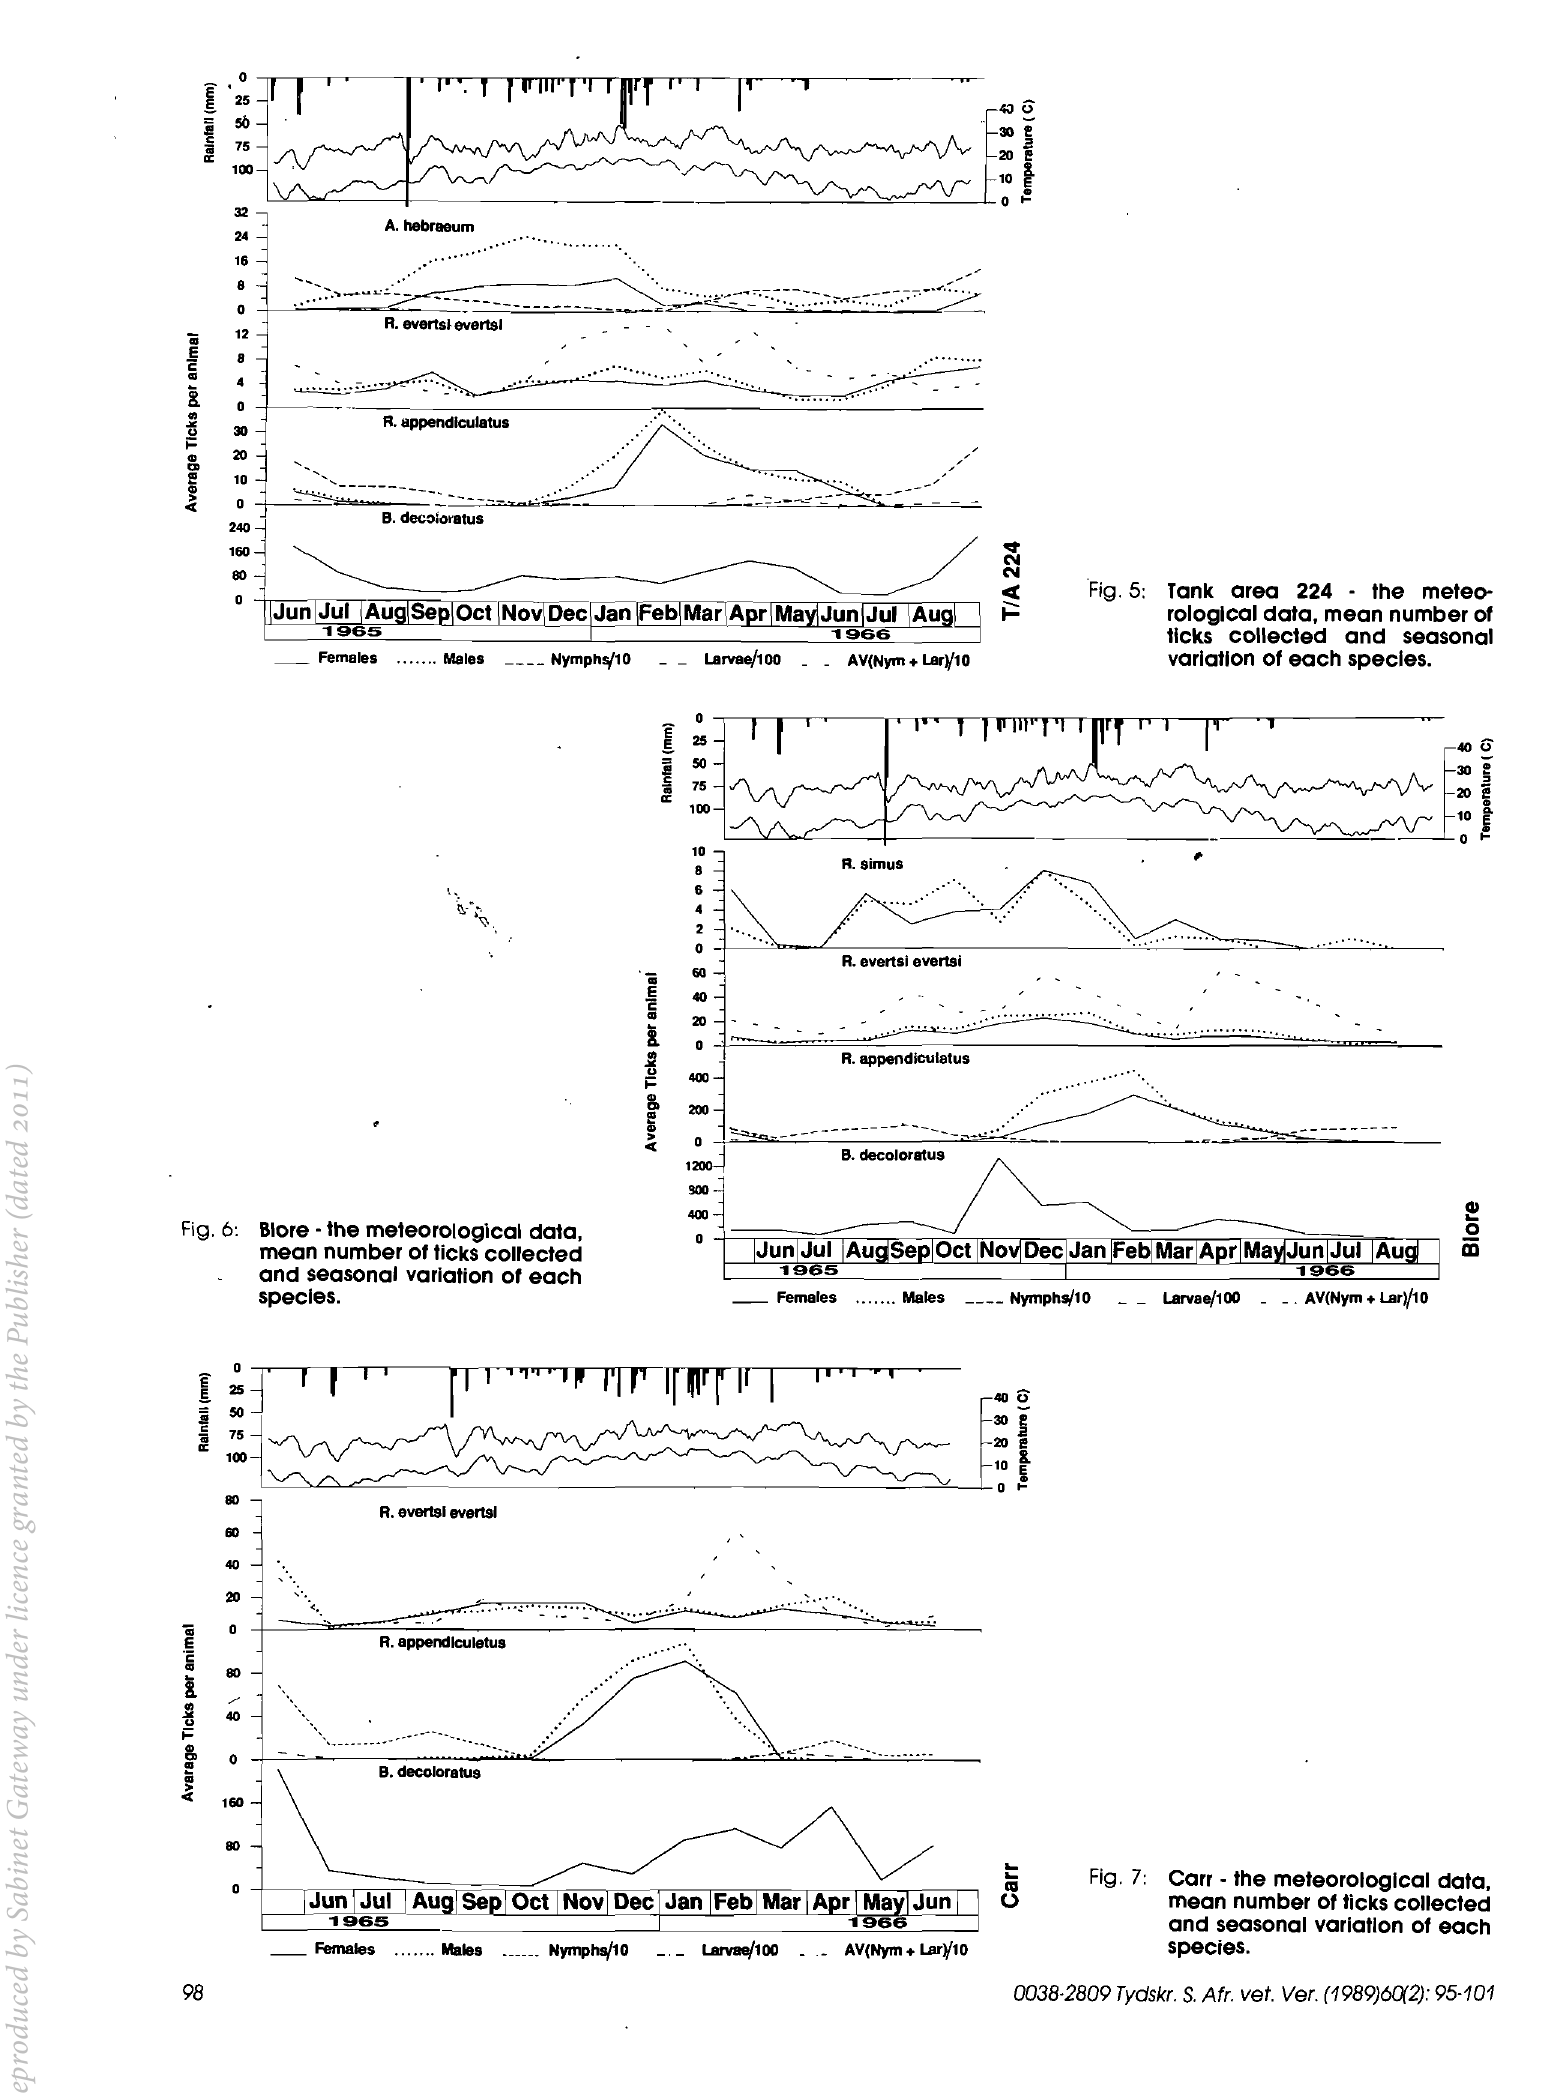
Fig. 5: Tank area 224 . the meteo rological data, mean number of ticks collected and seasonal variation of each species.